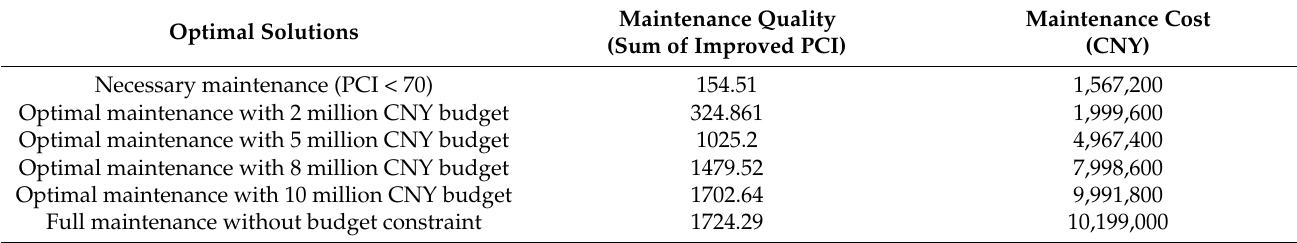
Table 4. Optimal solutions obtained by MMQLB model with different